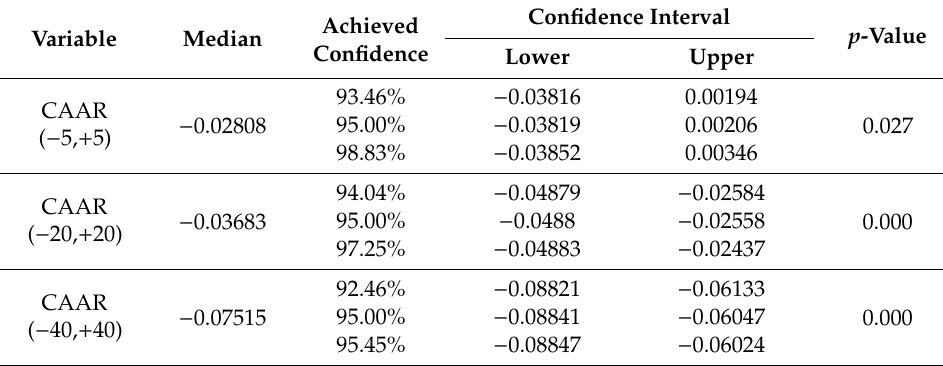
Table 5. Sign test on